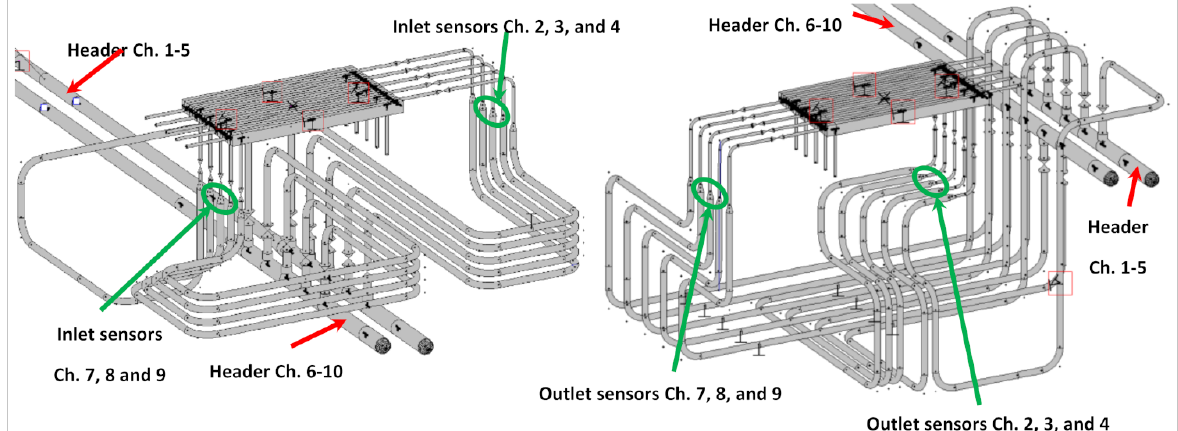
Figure 2. Arrangement of the pipes feeding the